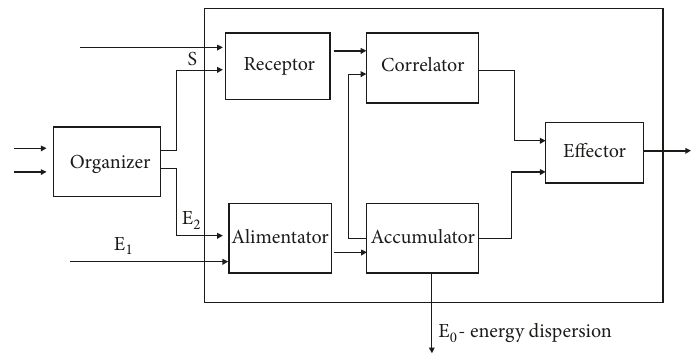
Figure 1: Cybernetic scheme of the controllable